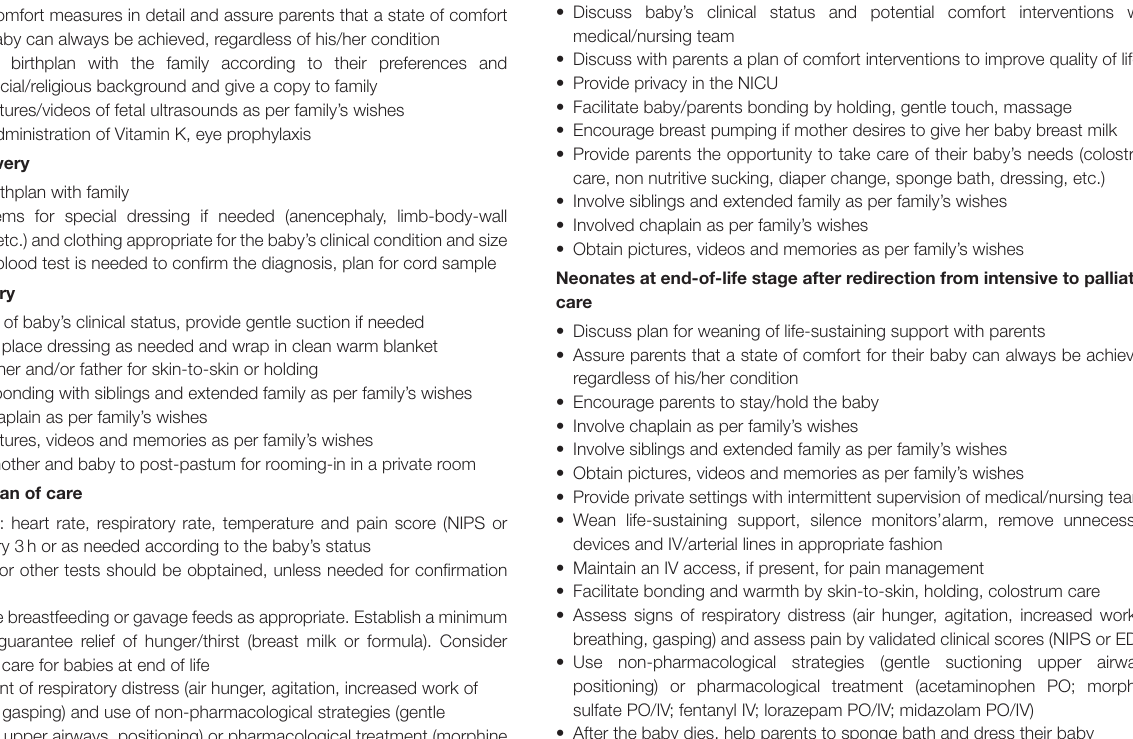
TABLE 1 | Guidelines to provide comfort to neonates prenatally diagnosed with life-limiting conditions. At prenatal counseling